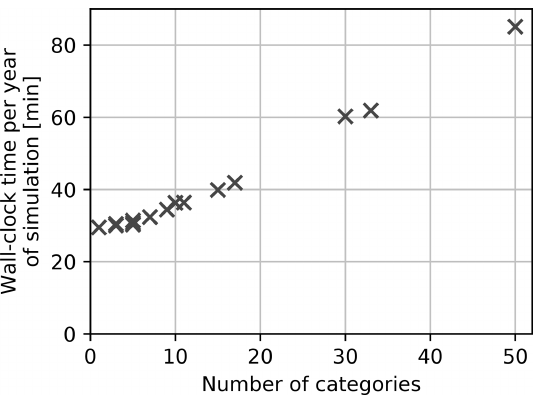
Figure A4. Wall-clock time required for 1 year of simulation as a function of the number of ice thickness categories. The coupled ocean–sea ice model is run on 260 cores. The computing times indicated in this figure correspond to the average over the first 5 years of each